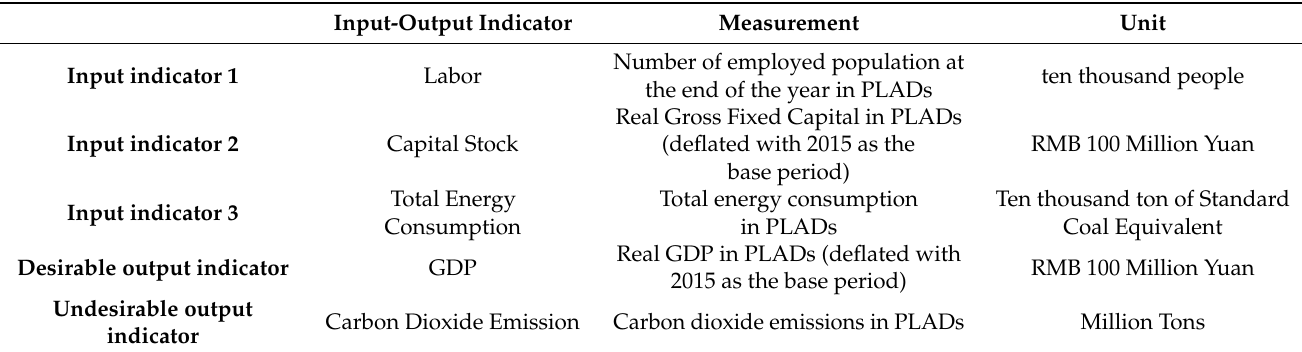
Table 2. Low-carbon economic efficiency evaluation index system.